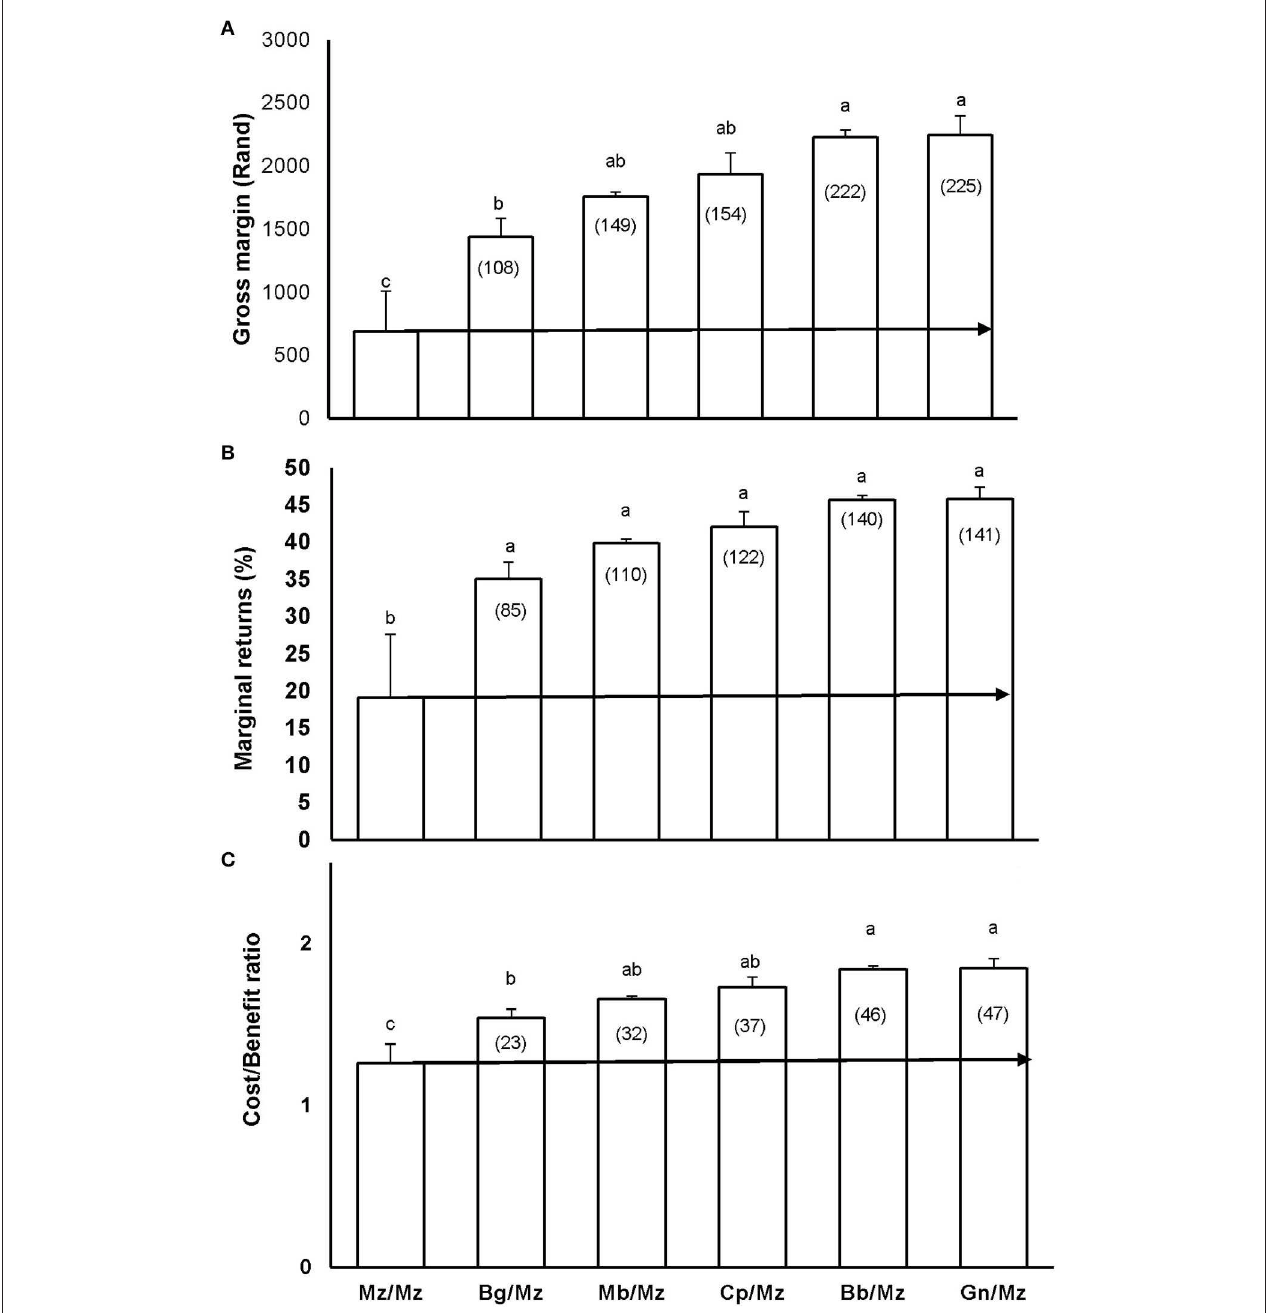
FIGURE 5 | A comparison of (A) gross margin, (B) marginal returns, and (C) cost/benefit ratio of maize after legumes with maize after maize at zero-N application at Nelspruit, Mpumalanga Province, in the 2012/2013 cropping season. Values in brackets represent % increases in yield of maize after legume over maize after maize in zero-N plots of the preceding crop. The horizontal line delineates increases in parameter caused by N20, N40, and N60 relative to N0. (Mz/Mz, maize after maize; Bg/Mz, maize after black gram; Mb/Mz, maize after mung bean; Cp/Mz, maize after cowpea; Bb/Mz, maize after Bambara bean; and Gn/Mz, maize after groundnut).